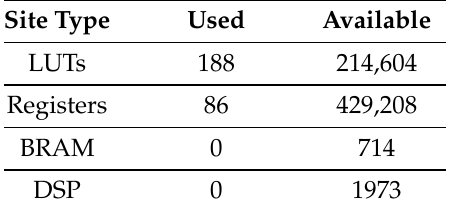
Table 3. True prime random number generator (TPRNG) resource